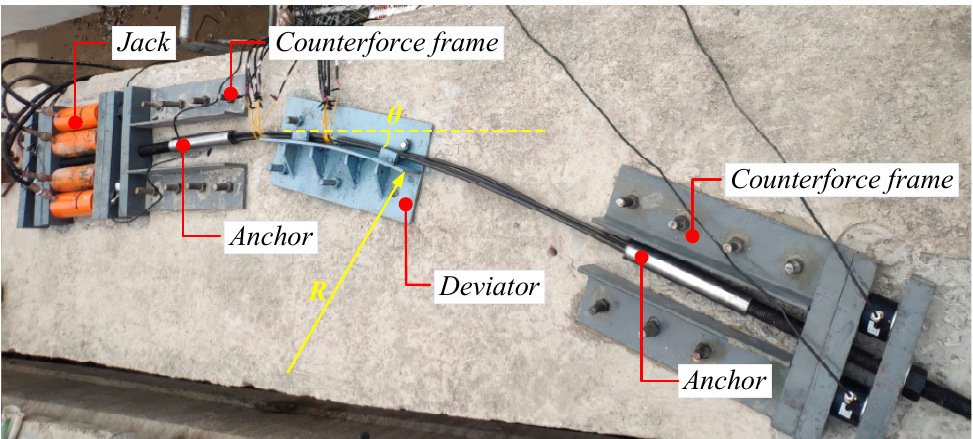
Figure 6. Tests of CFRP cables under bending.